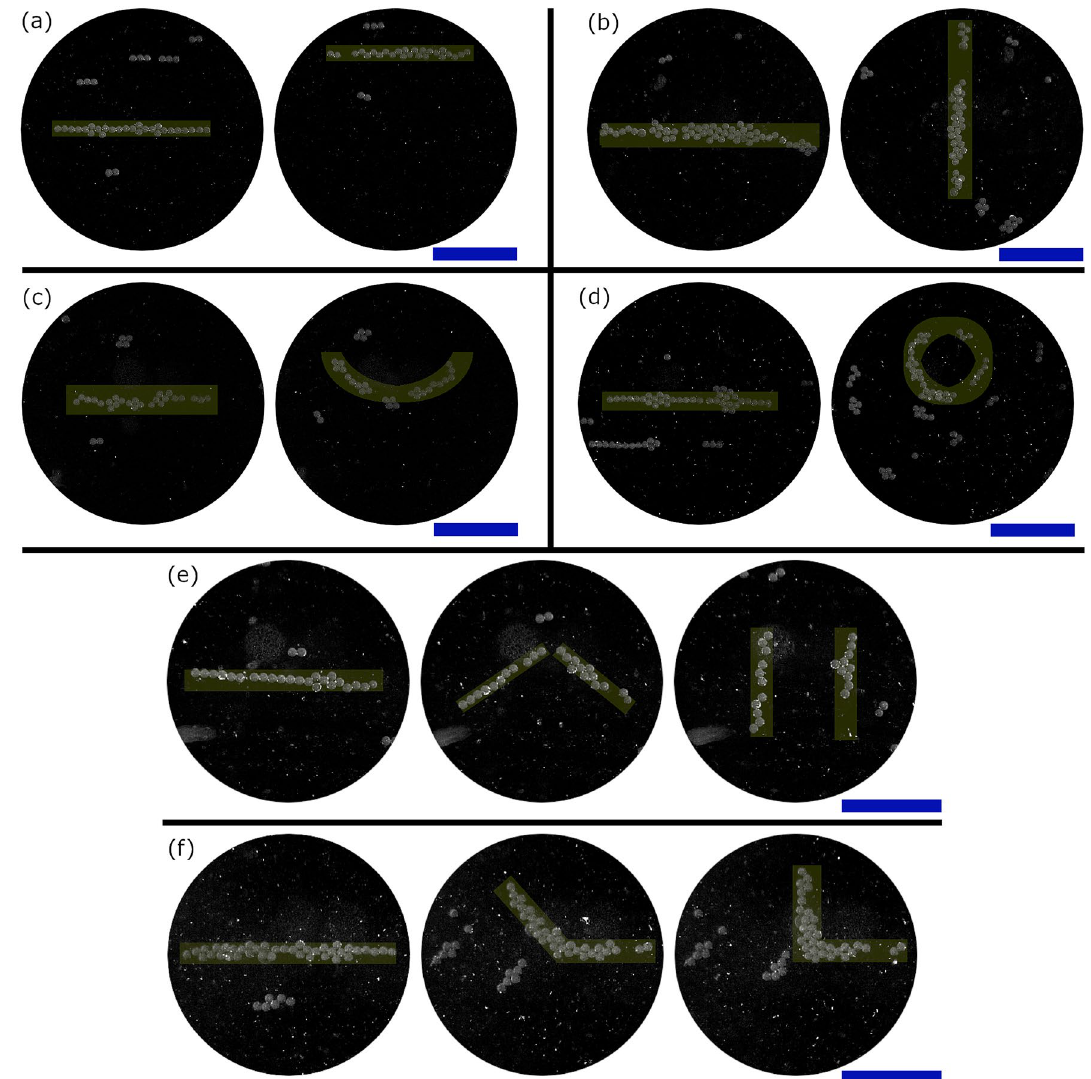
Figure 7. By incremental movement of the switched low impulse force fields the line can be dynamically ( a ) moved, ( b ) rotated or reshaped into ( c ) an arc or ( d ) a circle. A line can also be manipulated in two halves. ( e ) shows the line being split into two half lines and rotating in opposite directions while ( f ) shows one half line being rotated whilst the other half is held in location to form an ‘L’ shape like that shown in Fig. 3d. The blue scale bar is 1 mm. These operations can be seen happening in Supplementary Video